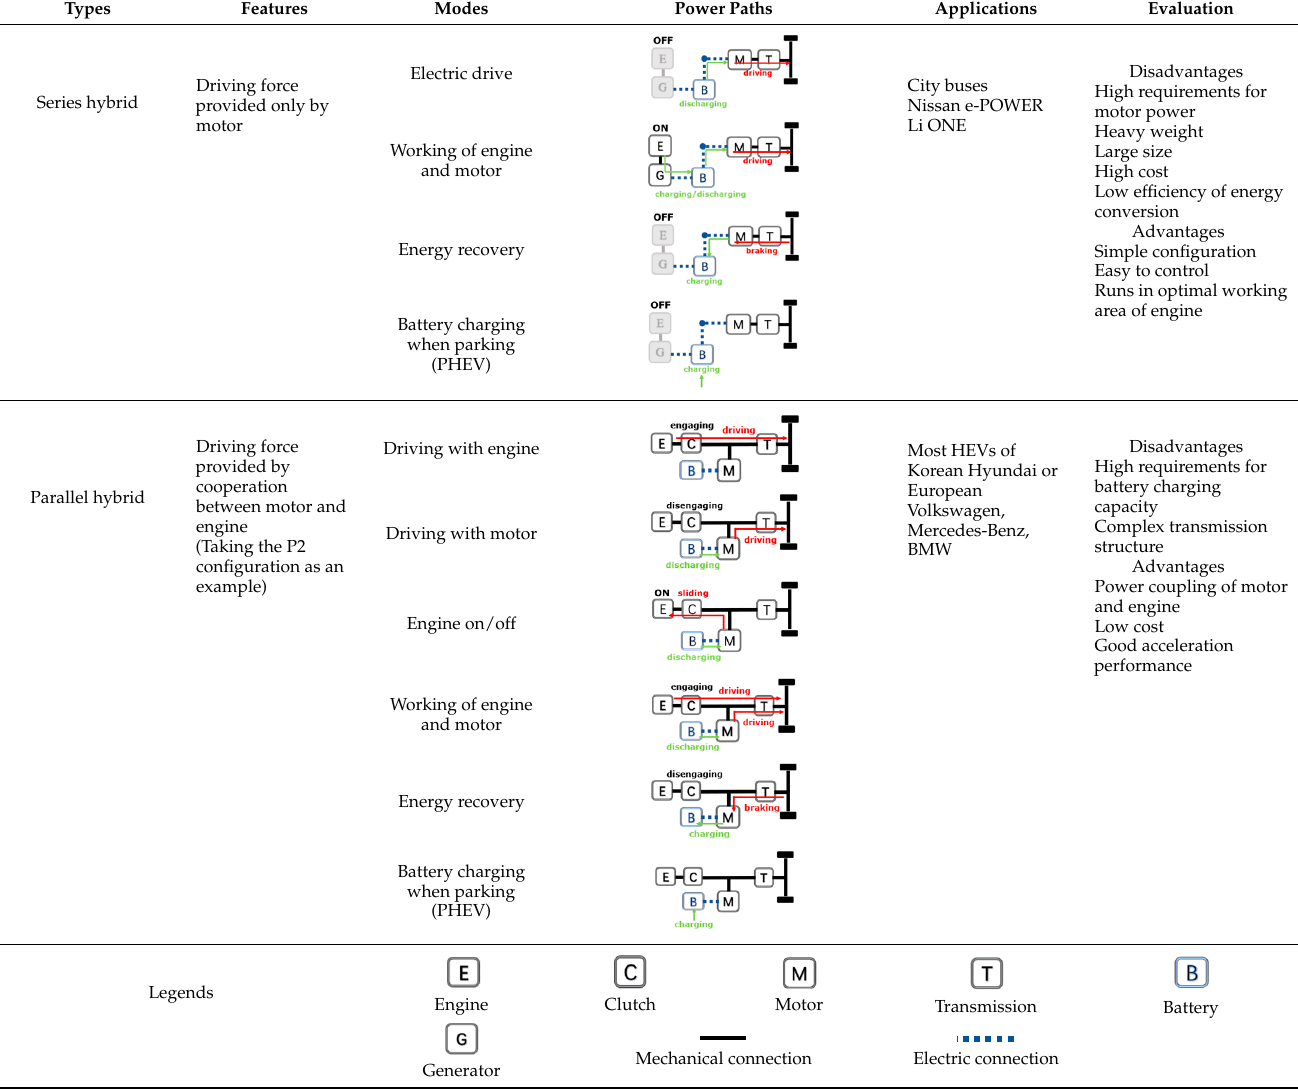
Table 2. Features and applications of parallel P0–P4 configurations [11,12].